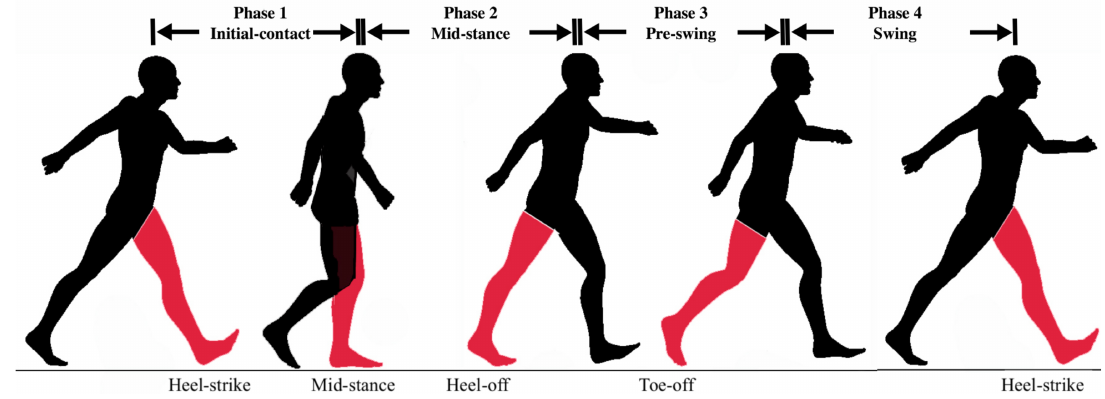
Figure 2. The gait phases